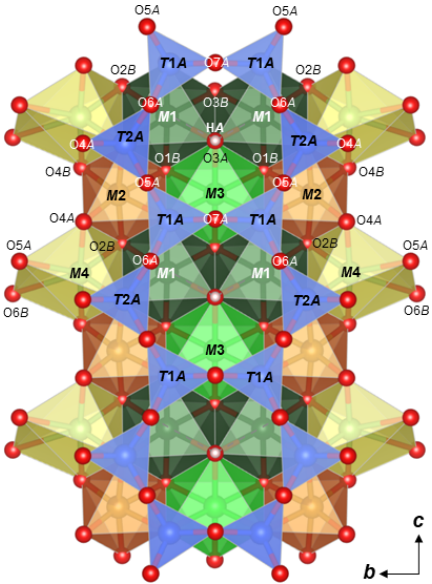
Figure 3. Crystal structure of ferro-ferri-holmquistite projected onto (100) showing the configuration of the A chain with M 1–4 polyhedra drawn with VESTA3 (Momma and Izumi,